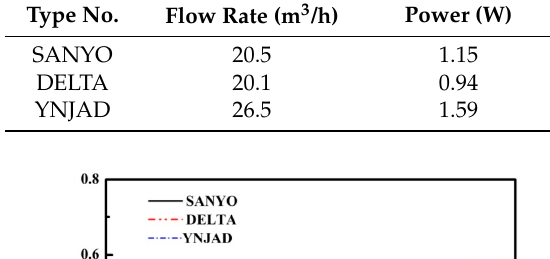
Table 6. Different types of cooling fan for optimization.